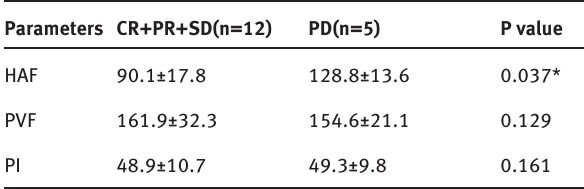
Table 3: Parameters for patients before treatment at CR+PR+SD and PD group according to RECIST